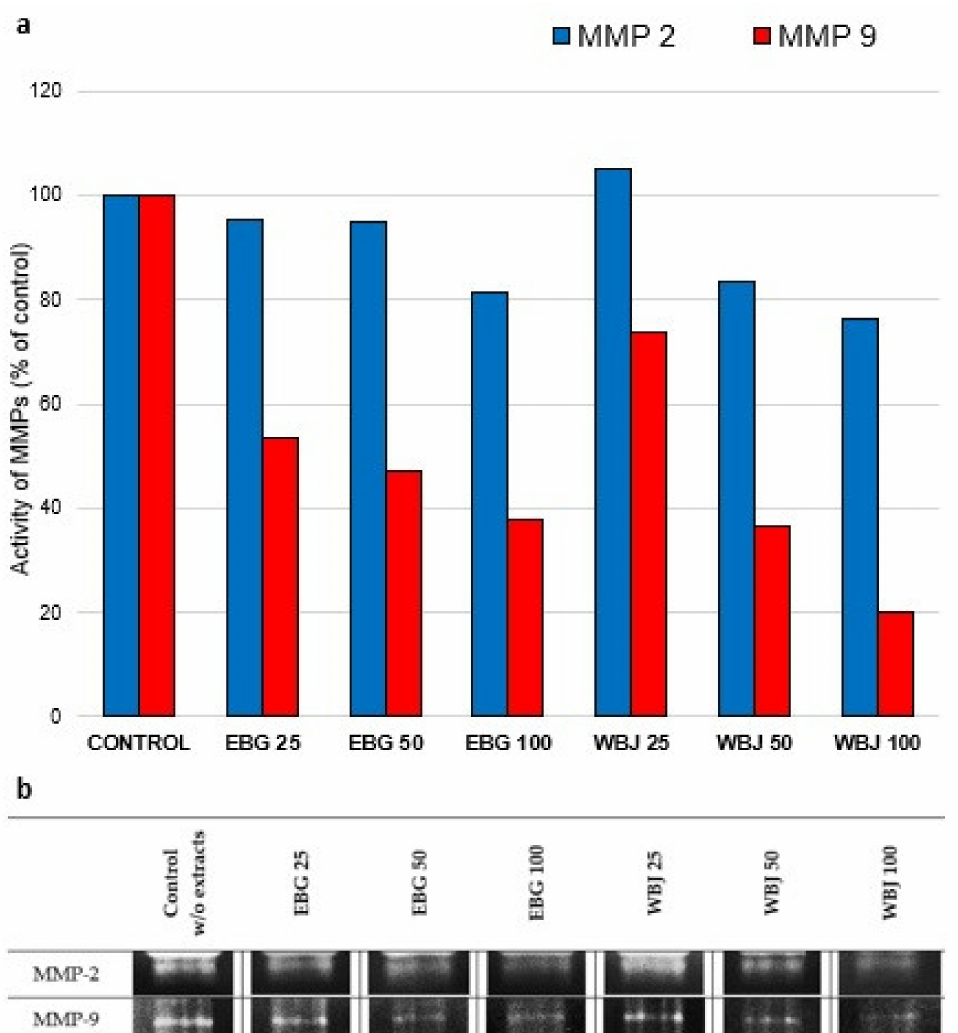
Figure 9. Effect of 70% ethanolic extract of barley grass (EBG) and water extract of young barley juice (WBJ) at doses of 25, 50 and 100 µ g/mL on MMP-2 and MMP-9 expression in the culture medium of NHSF line fibroblasts in the “UV 24 h” research model. MMPs secretion was presented as a percentage of control without application of extracts ( a ). Figure ( b ) shows images of gels (medium concentrated by 35-fold; 10 µ g of